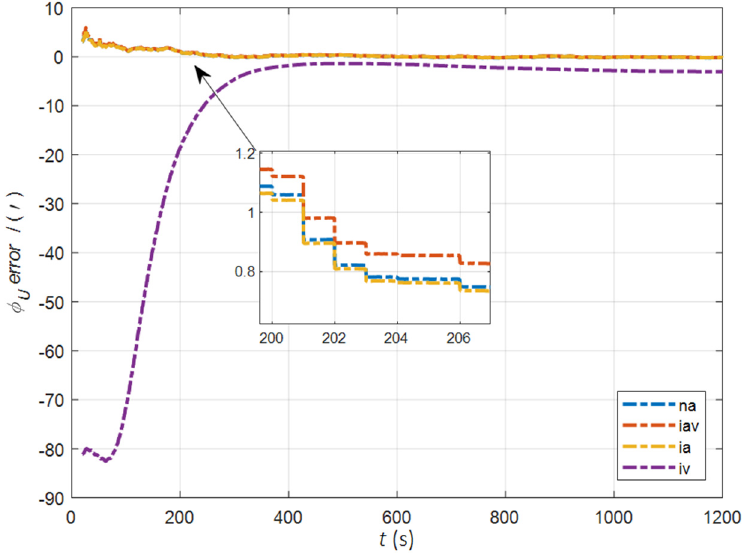
° ° . Figure 5. The error curves of φ U in the cases of the initial misalignment angles [ 0.2 ◦ 0.2 ◦ 2 ◦ ] T .